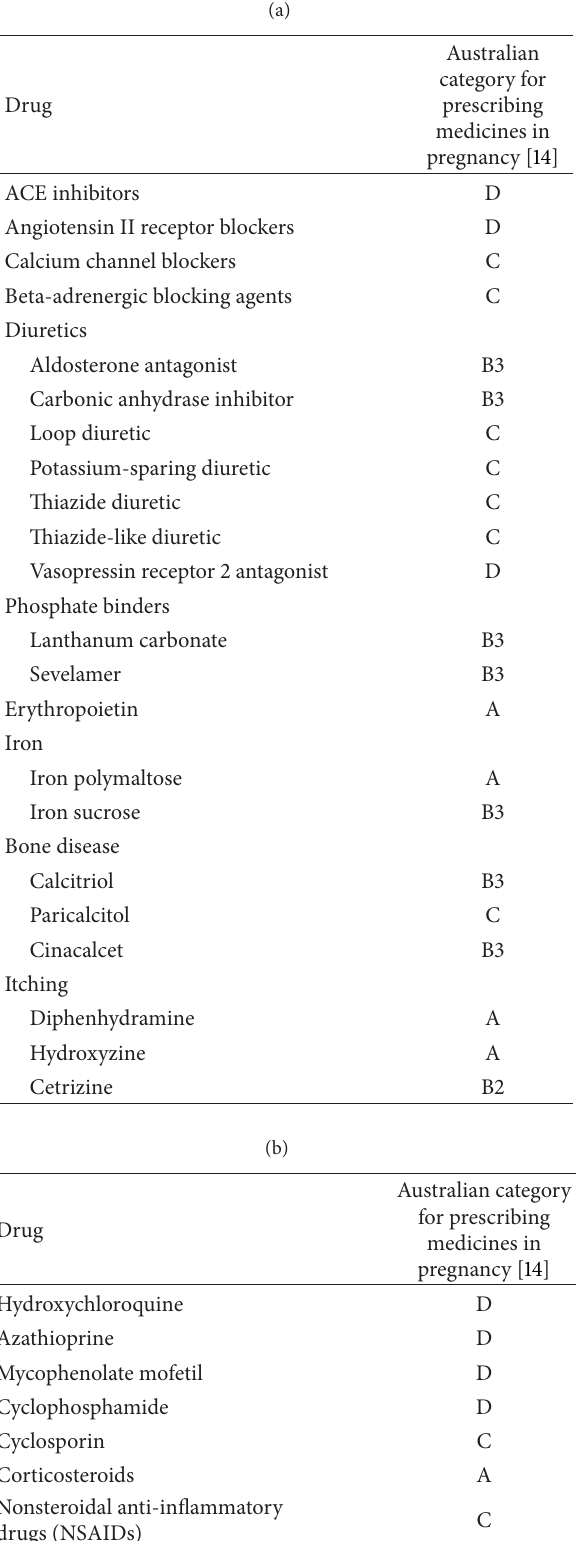
Table 2: (a) Safety in pregnancy: drugs commonly used in dialysis. (b) safety in pregnancy: drugs commonly used in systemic lupus erythematous. (c) Key to categories for prescribing medicines in